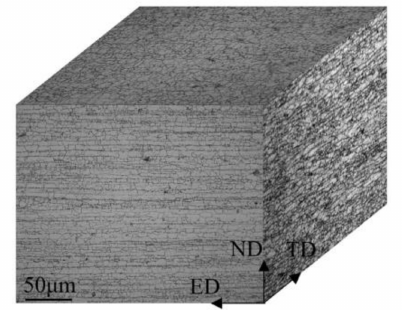
Figure 3. Optical micrograph of 7020 aluminum